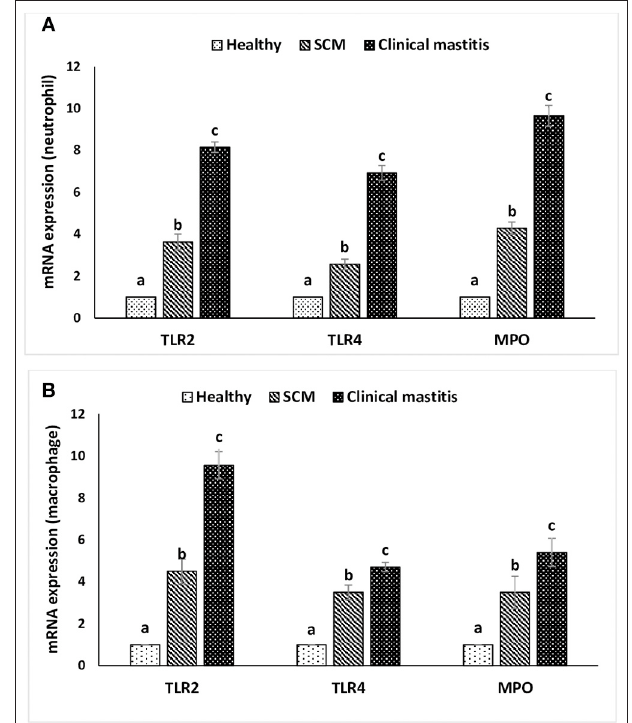
FIGURE 6 | Relative mRNA expression of toll-like receptors (TLR2, TLR4) and myeloperoxidase (MPO) in milk neutrophils (A) and macrophages (B) of healthy, subclinical mastitis (SCM), and clinical mastitis Sahiwal cows. Data were expressed as mean ± SEM. Means statistically ( p < 0.05) different between the groups are shown with small superscript letters (a–c).